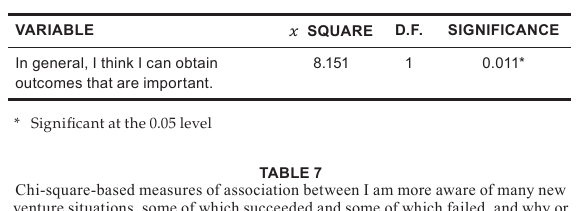
table 6 Chi-square-based measures of association between I don’t mind being committed to meet a regular payroll if it means that I can have a chance at greater financial